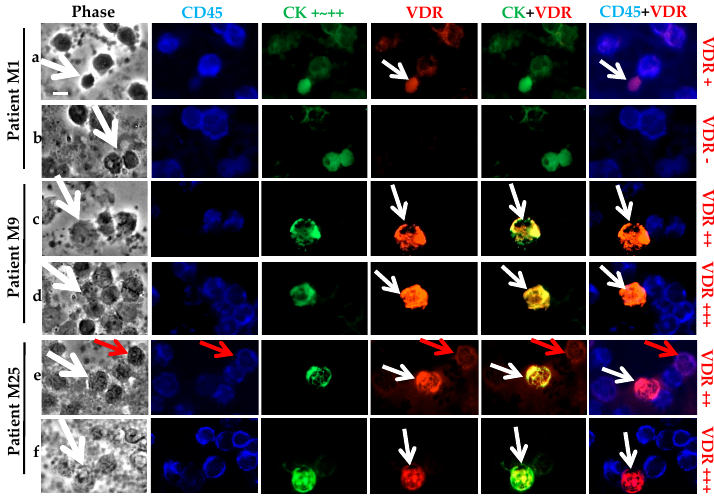
Figure 5. Particular subtypes of CK positive CD45 negative cells. Triple fluorescence labeling of CD45, CK, and VDR was performed on 10 6 PBMCs from patients, with parallel analysis. Distinct subtypes of CTCs ( with white arrow ) were observed: patient M1 ( a , b ) with more than 500 CTCs identified and patients M9 ( c , d ) and M25 ( e , f ) with superimposed VDR and CK labeling. VDR staining was also seen in PMBCs ( with red arrow ), with superimposed VDR and CD45 labeling. Original magnification, ×40. Scale bar (white bar in the upper left image), 10 μ m.